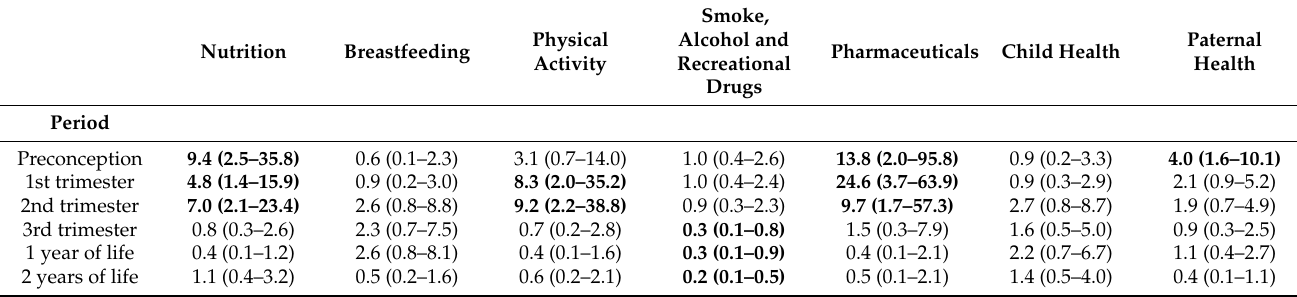
Table 4. Association between users’ time period and video